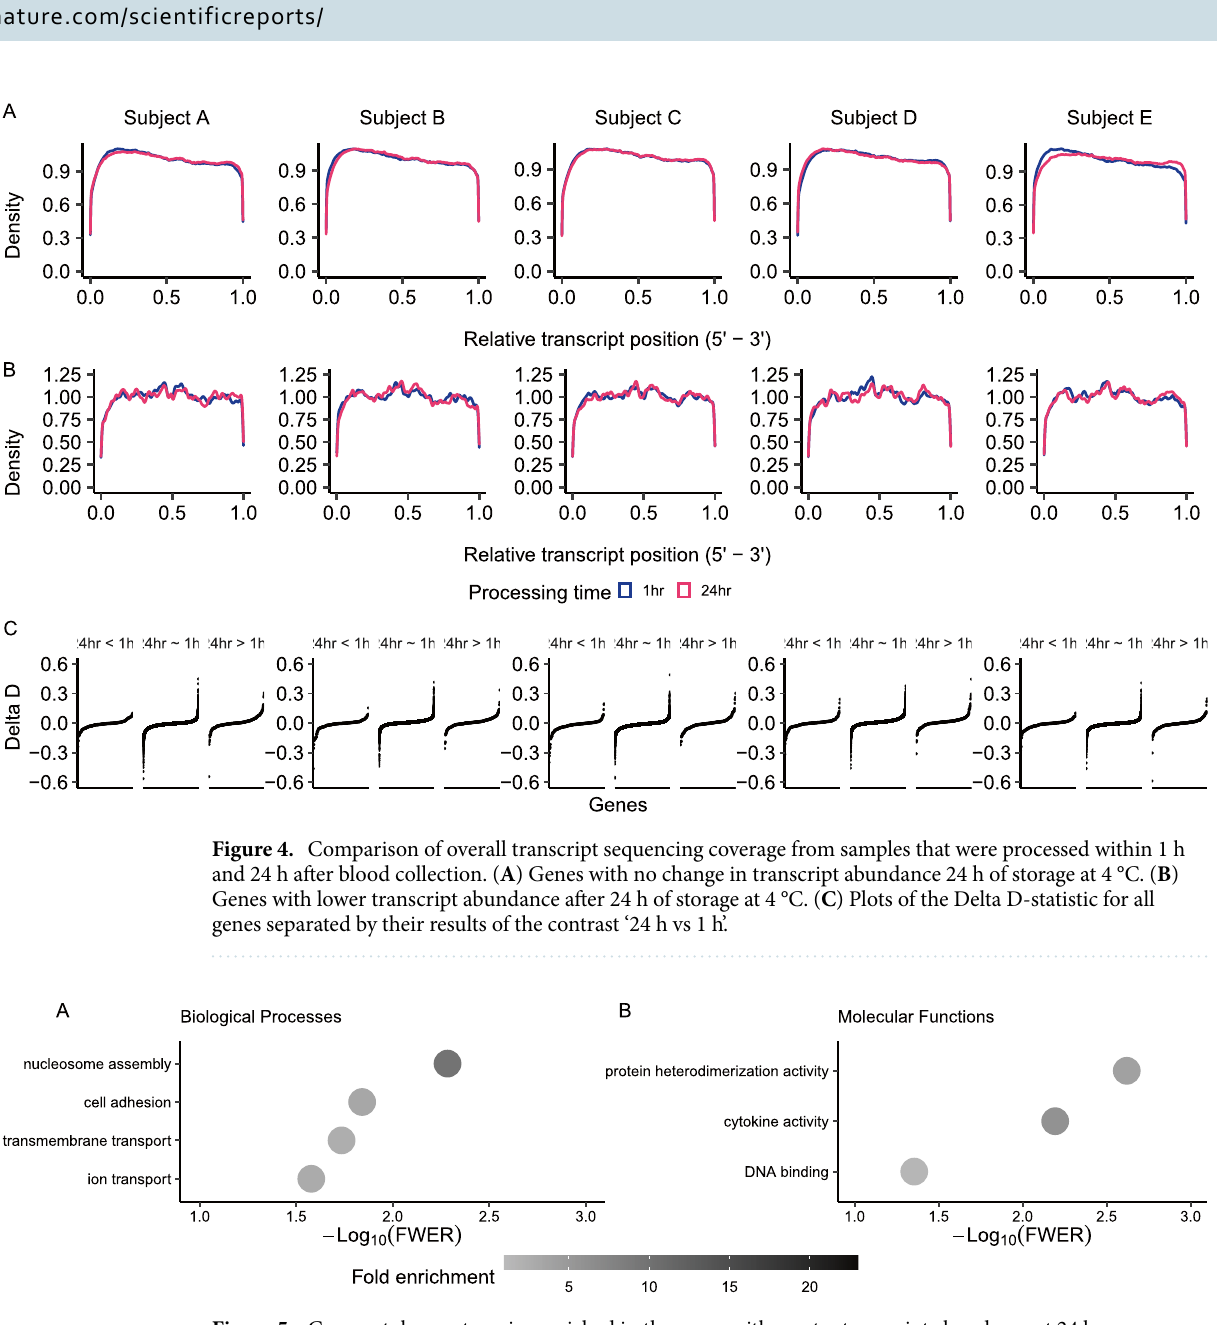
Figure 5. Gene ontology categories enriched in the genes with greater transcript abundance at 24 h versus one h. ( A ) Biological processes and ( B ) Molecular functions. To improve readability, only categories with more than five genes are displayed on the graphs, please, see Supplementary Table S2 and S3 for a full list of categories and the associated genes with their